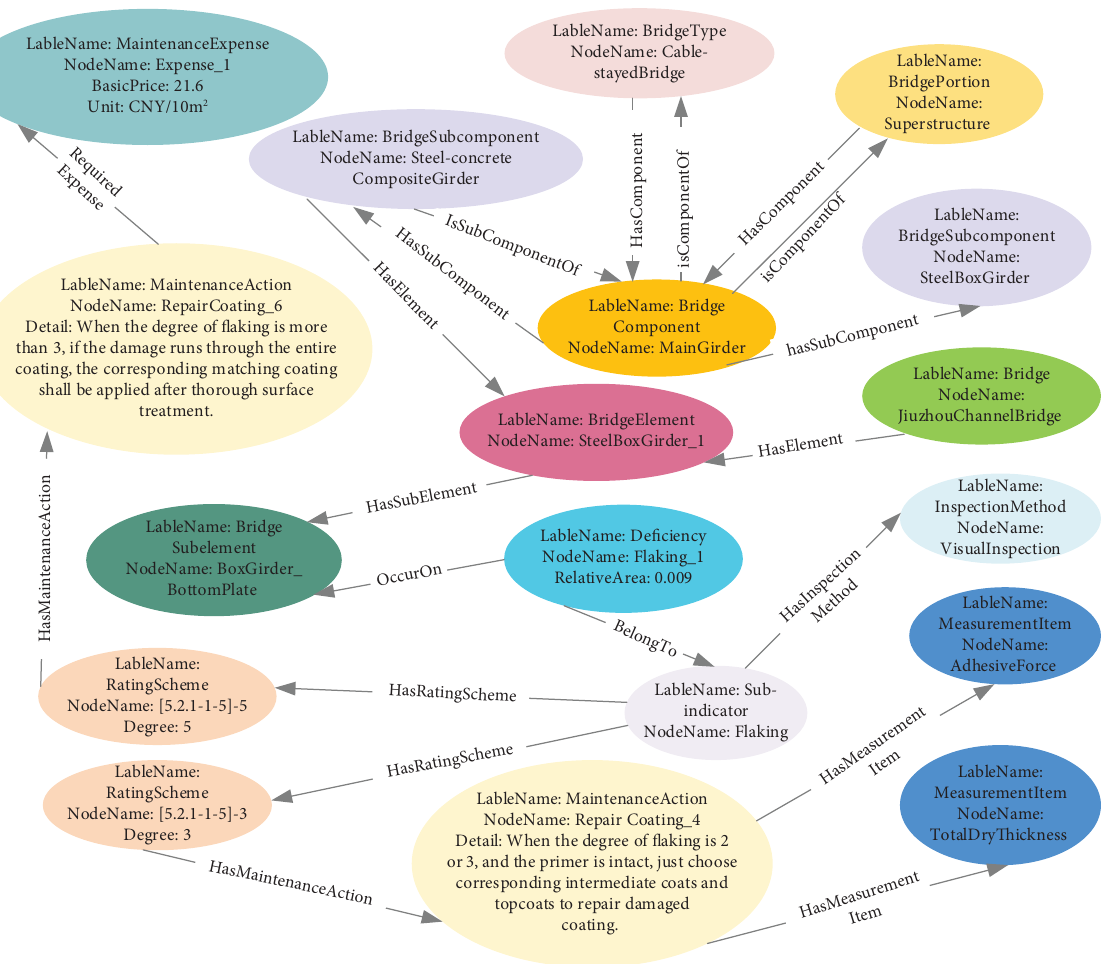
Figure 12: A schematic diagram of the BMKG (partial view).